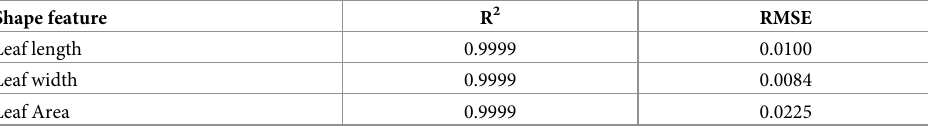
Table 1. Performance values of image processing technique for measuring the leaf shape